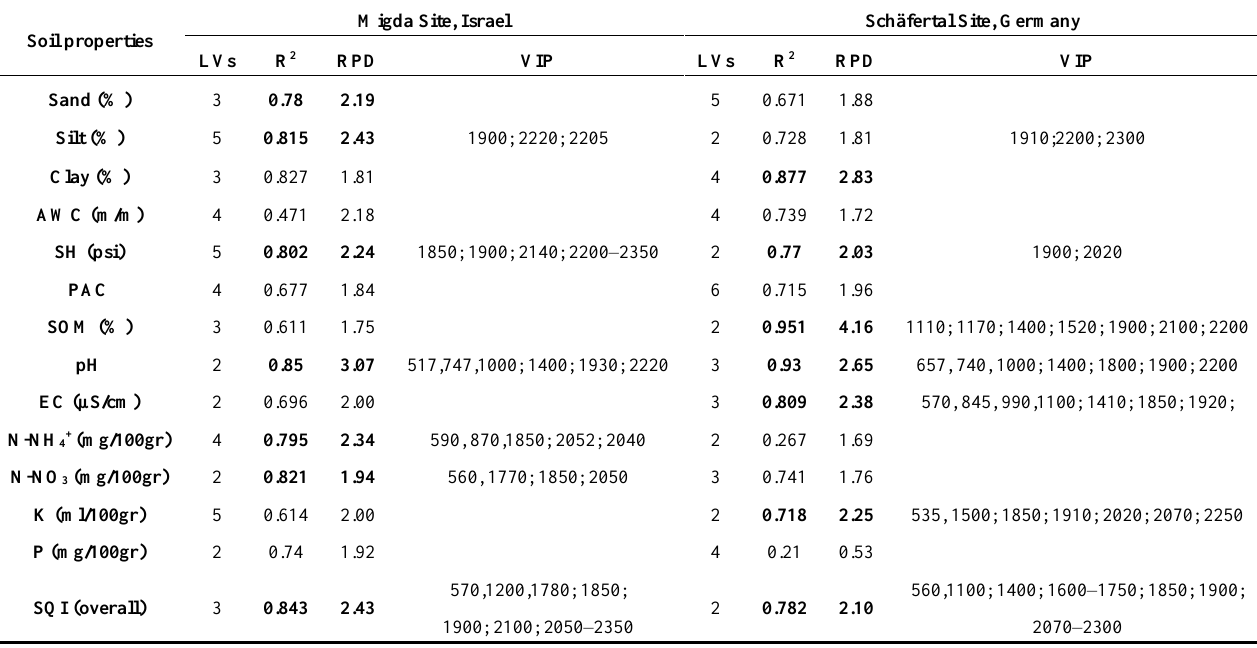
Table 7. Results of the partial least squares-regression (PLS-R) analysis in terms of spectral regions that are indicative for the soil properties in the two study systems: (1) Migda site, Israel, and (2) Schäfertal site, Germany. Statistics include the number of latent variables (LVs) selected in the PLS-R model, correlation of determination (R 2 ),